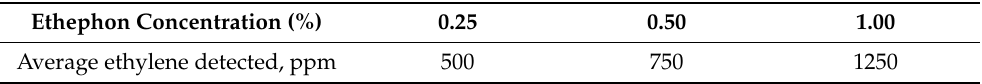
Table 1. Average ethephon concentration decomposed into ethylene in 24